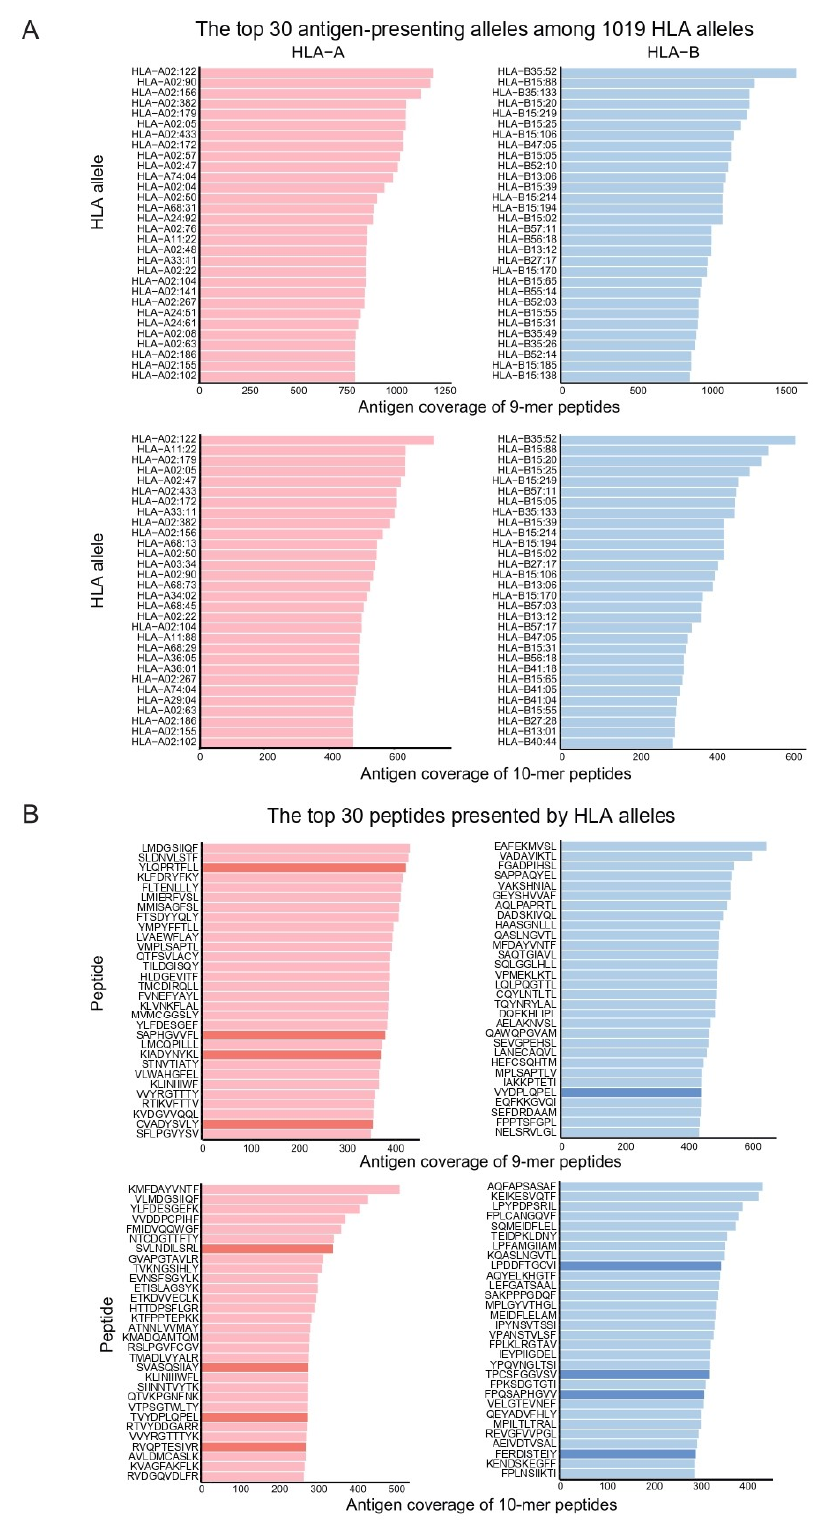
Figure 4. ( A ) The top 30 antigen-presenting alleles in descending order. The red and blue bars indicate the antigen presentation counts for HLA-A and HLA-B, respectively. The antigen coverage in all figures is the result predicted by MHCflurry. ( B ) The top 30 peptides presented by HLA alleles in descending order. The character on the bar indicates the SARS-CoV-2 domain from which the peptide is derived. The red and blue bars indicate the antigen presentation counts for HLA-A and HLA-B, respectively. The bars in a dark color indicate a peptide derived from the spike